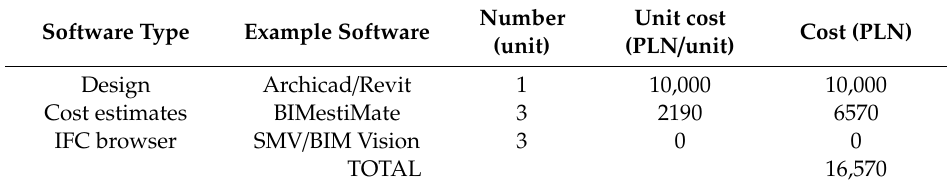
Table 4. Costs of implementing BIM in a construction